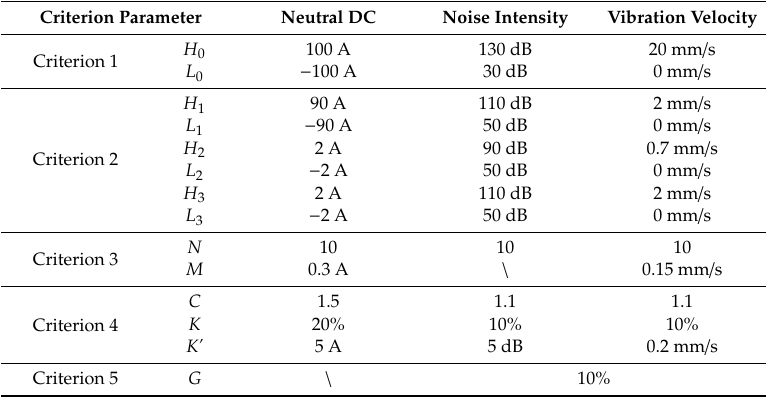
Table 3. Parameter setting of data validity evaluation